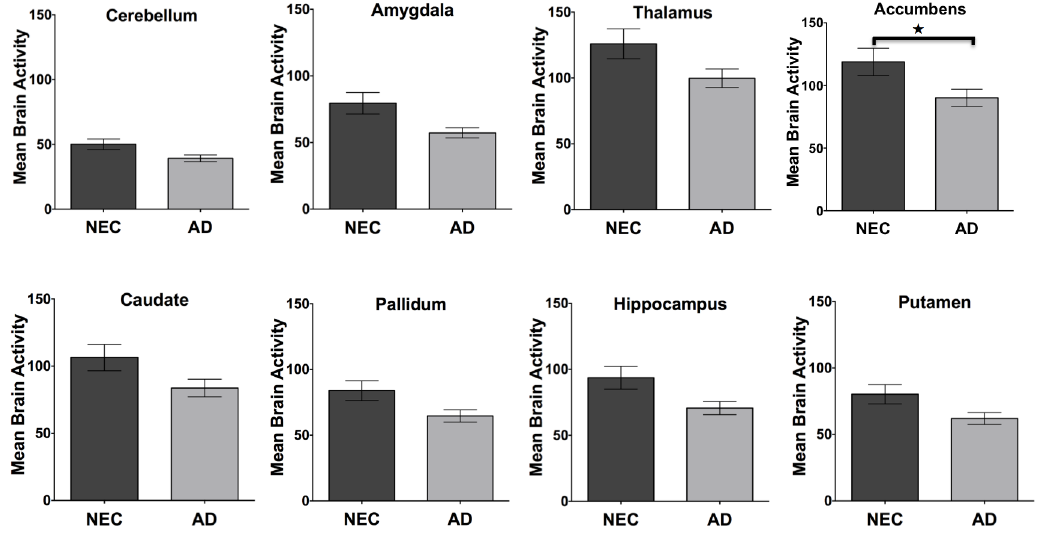
Fig 4. Regional brain activity. The averagebrain activity measuredby RS-fMRI in NEC and Alzheimer disease subjects in the cerebellum,amygdala,thalamus, accumbens, caudate, pallidum,hippocampus, and putamen. The error bars represent the standard error of the mean and asterisks show significantdifferences betweengroups(adjusted p value, Bonferroni).